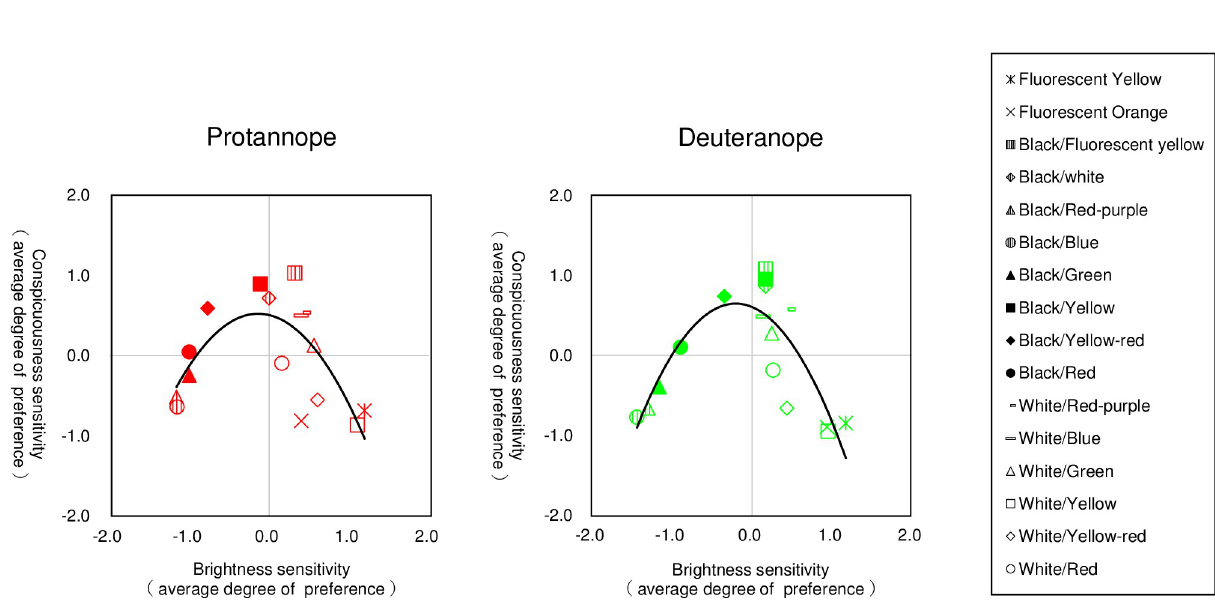
Fig 8. Scatterplot of brightness sensitivity and conspicuousness sensitivity. The vertical axis represents the average degree of preference for the sense of conspicuousness, and the horizontal axis represents the average degree of preference for the sense of brightness. Black/fluorescent yellow is highly visible because it is bright and easily noticeable, while black/blue is less visible because it is dark and less noticeable. There is no correlation between brightness sense and conspicuousness sense.